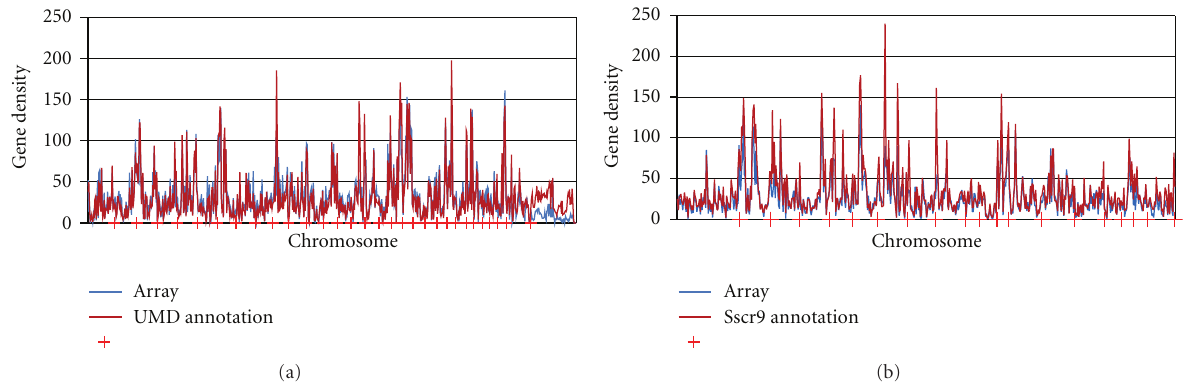
Figure 2: Genome-wide representation of oligonucleotide target sequences on the BOM and SPAM. The positional distribution of targets (blue) is plotted relative to the (a) bovine (BOM), or (b) porcine (SPAM) chromosomes (red) to demonstrate the genome-wide representation of targets on the